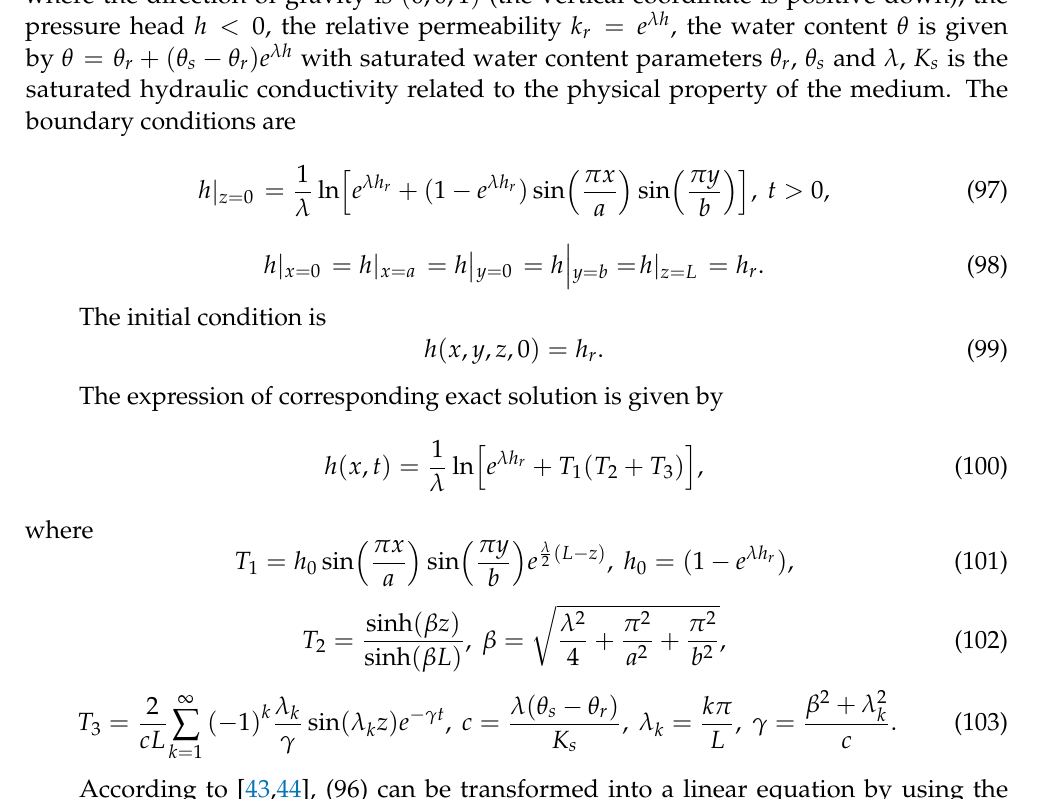
=  given by the HIM method. Figure 12. Calculation results on layers z = k /10, ( k = 0,1, · · · ,10 ) given by the HIM